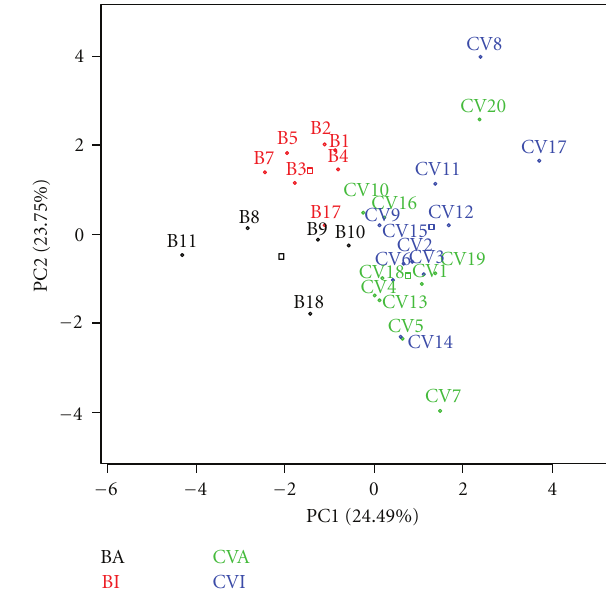
Figure 4: Graph of